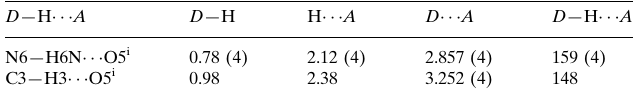
Hydrogen-bond geometry (A˚ , (cid:2)